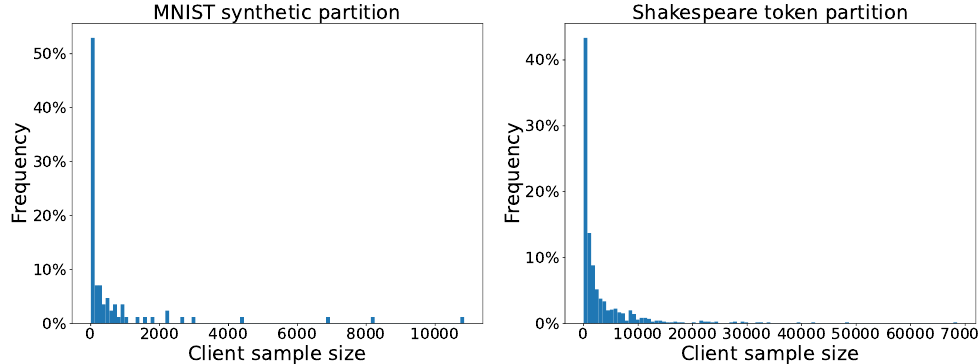
Figure 2. Histogram of the sample partitions of the MNIST ( left ) and Shakespeare ( right )